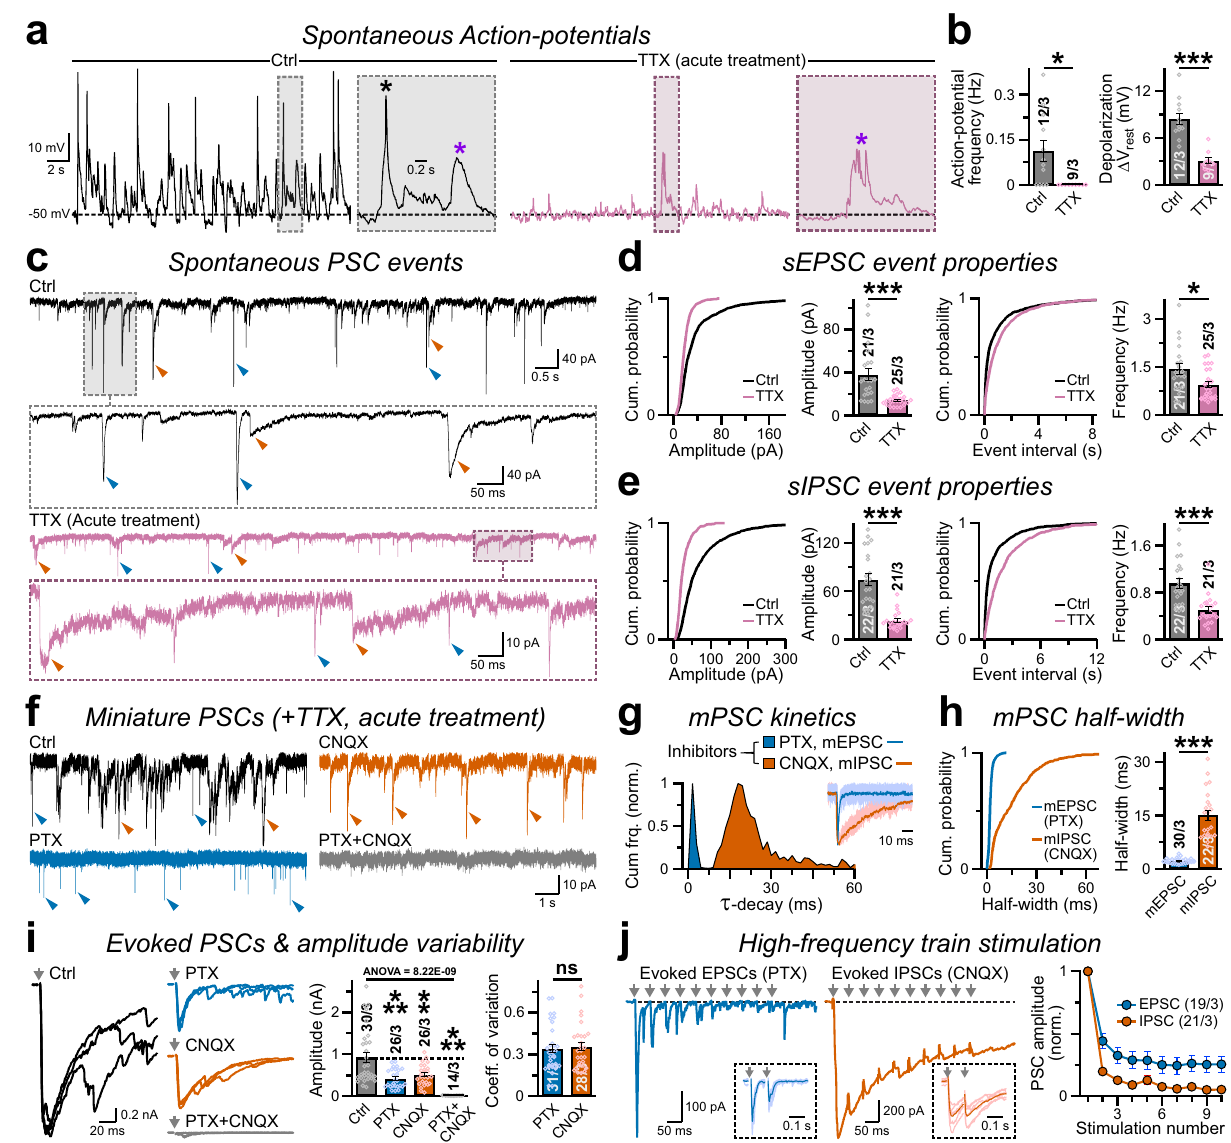
Fig. 2 V57-induced synapses exhibit both miniature and AP-evoked GABA release. a Current-clamp recordings of spontaneous APs, in the absence (Ctrl, left) or presence of TTX (right). Insets, magni fi ed areas of the boxed regions with AP (black asterisk) or subthreshold depolarization (purple asterisk). b Average frequency of spontaneous AP (left) or total depolarization (right), without (Ctrl) or with TTX. c . Representative traces of sPSCs (boxed areas magni fi ed below) recorded in voltage-clamp mode from Ctrl condition vs. acute treatments of TTX, arrowheads pointing at events with fast (blue) vs. slow (red) τ -decay. d , e Probability plots and averages of event amplitude (left) and frequency (right) for sEPSC d or sIPSC e . f Representative traces of mPSCs recorded in the presence of TTX only (Ctrl), or after co-application of either CNQX, or PTX, or both (CNQX + PTX). Arrowheads indicate fast EPSC (blue) vs. slow IPSC (red) events. g , h Normalized frequency of τ -decay for miniature PSC events g ; Inset = 10 superimposed sample traces (light shades) and their corresponding averages overlaid (dark shades). Cumulative probability plots of event half-widths with summary graphs h , for PTX-resistance mEPSCs (blue) vs. CNQX-resistant mIPSCs (red). i Overlaid representative waveforms (left, stimulus artifacts replaced by arrows), average amplitudes (middle), and CV (right) of PSCs evoked by > = 3 consecutive presynaptic pulses, as recorded from indicated conditions. j Example traces (left) of EPSCs and IPSCs evoked by train of pulses (arrows); Insets are successive paired stimulations of presynaptic inputs with Δ t = 50 ms, presented as superimposed trials (6 consecutive paired-pulses, light shades) with average traces (dark shades). All PSC amplitudes normalized to corresponding 1 st pulse (right). Both EPSCs and IPSCs manifested signi fi cant synaptic depression, but of a different magnitude possibly due to different extents of desensitization and/or saturation of postsynaptic AMPARs vs. GABA A Rs, and therefore, could not be directly compared as a proxy for presynaptic release probabilities. All numerical data are means ± SEM, with total number of neurons recorded/experimental batches, and data-points plotted as open circles. Statistical signi fi cances were evaluated either by two-tailed, unpaired, Student ’ s t-test (Skewness and Kurtosis values − 2 > ≈ and ≈ < 2), or two-sided, nonparametric Mann-Whitney U-test, for *** P < 0.005; * P < 0.05; ns = not signi fi cant, P > 0.05. Multiple groups were compared by one-way ANOVA ( i , with P